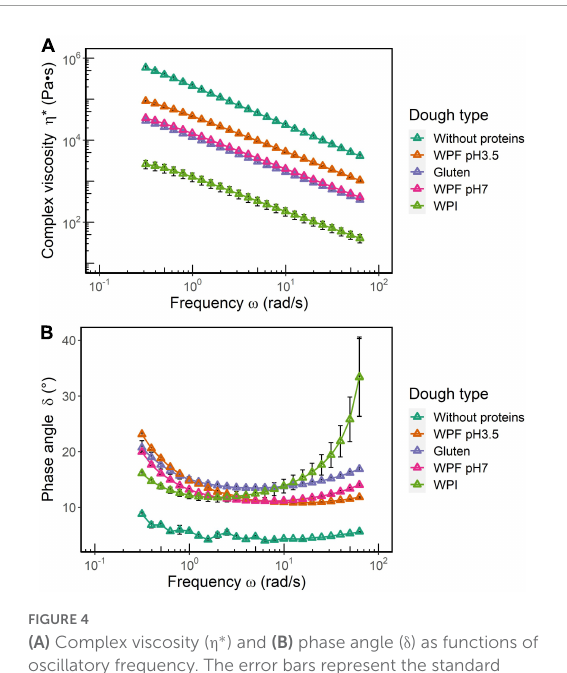
FIGURE4 (A) Complex viscosity ( η ∗ ) and (B) phase angle ( δ ) as functions of oscillatory frequency. The error bars represent the standard